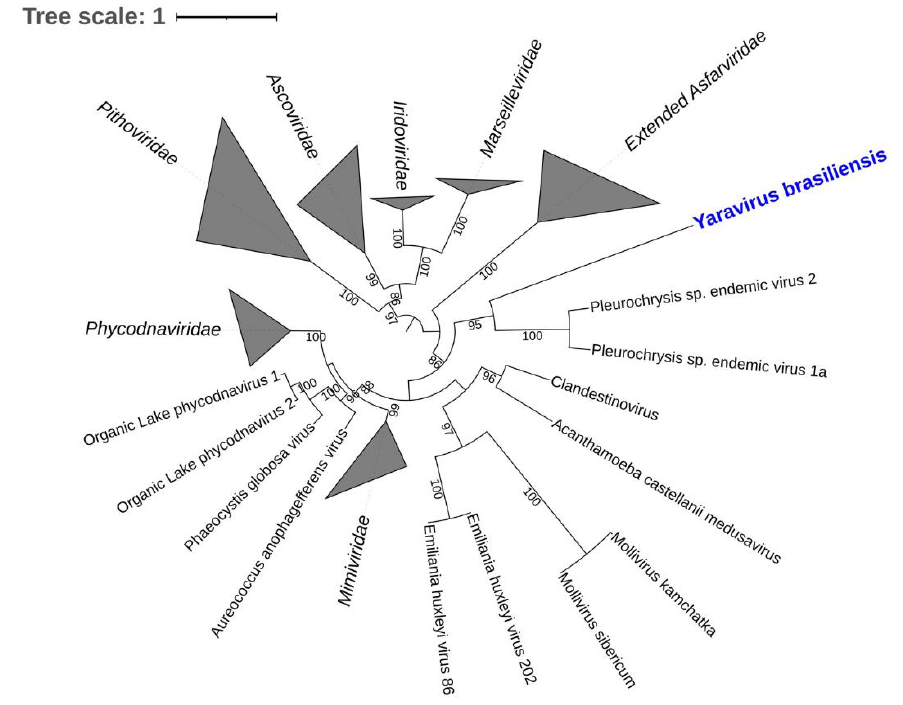
Figure 4. Maximum likelihood phylogenetic tree based on amino acid sequences of major capsid protein of Nucleocytoviricota. Yaravirus brasiliensis is bold and highlighted in blue. Sequences were aligned using Muscle [48] and low conserved regions were removed using trimAl [49]. The tree was built using IQ-TREE [50] with 1000 ultrafast bootstrap replicates and the VT+R3 model chosen by ModelTest according to Bayesian Information Criterion. The tree was visualized in iToL [51]. The tree scale indicates the substitution rate.